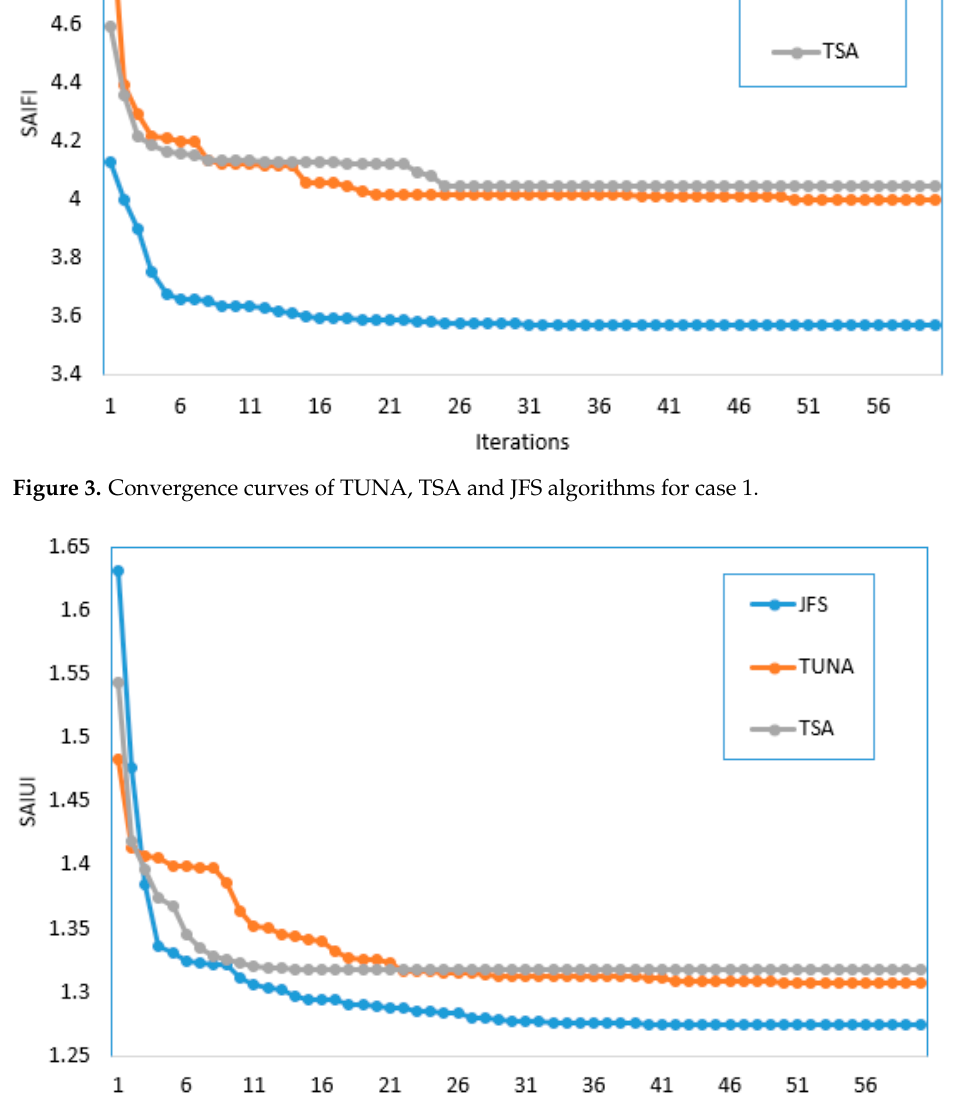
Figure 4. Convergence curves of TUNA, TSA and JFS algorithms for case 2.